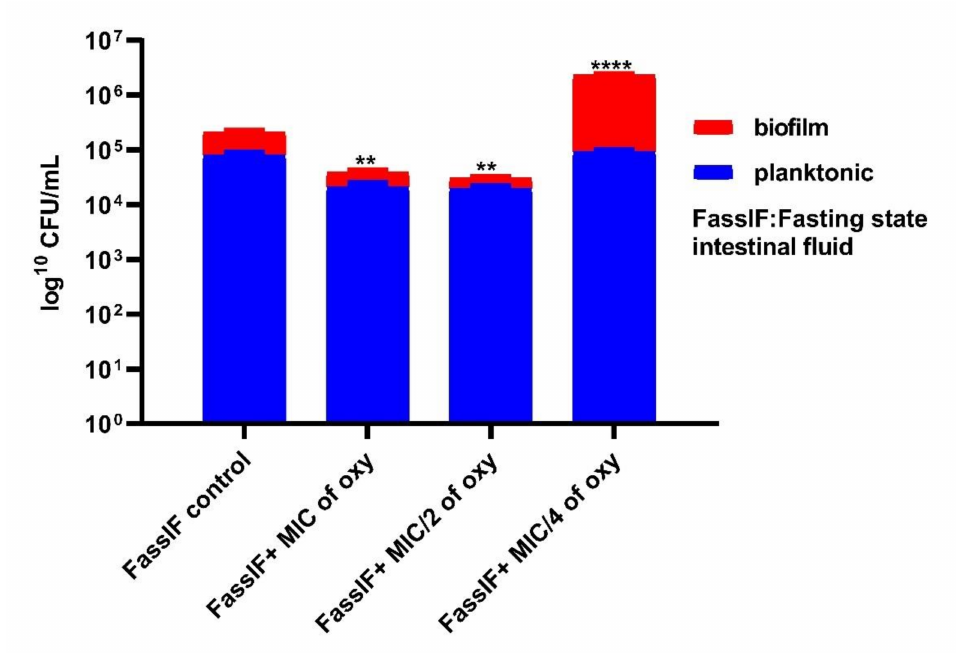
Figure 10. Viable counts (log CFU/mL) of L. fermentum ASBT-2 after 3 h of exposure to fasting state intestinal fluid (FaSSIF). **** Significantly different ( p ≤ 0.0001); ** significantly different ( p ≤